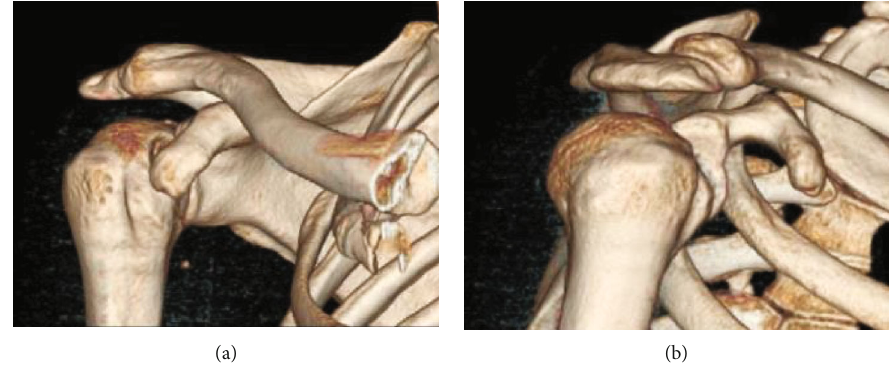
Figure 1: 3D CT reconstruction of an AP (a) and lateral view of the shoulder (b).